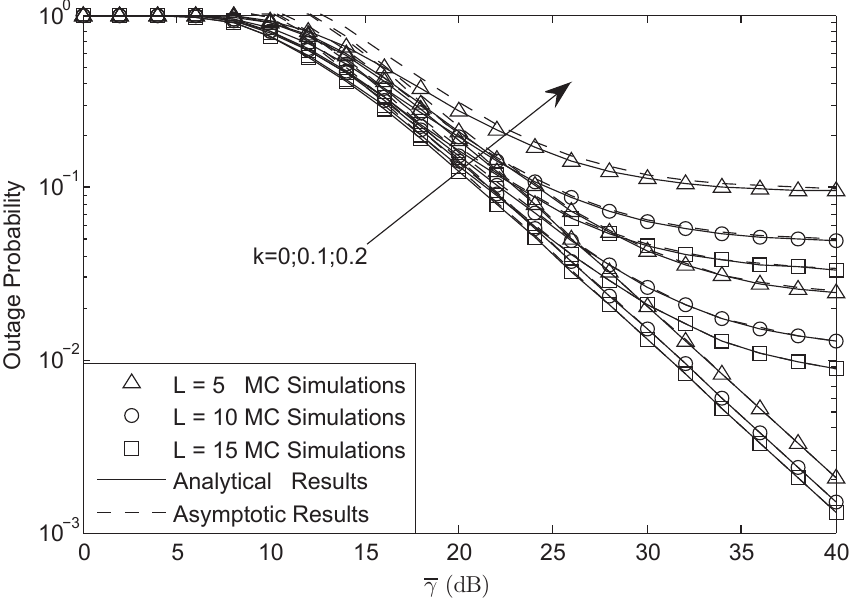
Figure 7. OP of the system versus different L with M = 3, σ = 0.8 and γ 0 = 3